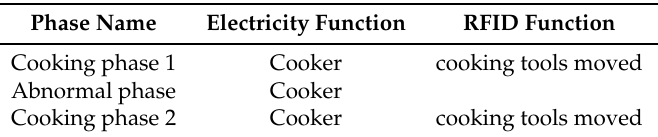
Table 9. Result of our algorithm on data from Figures 22 and